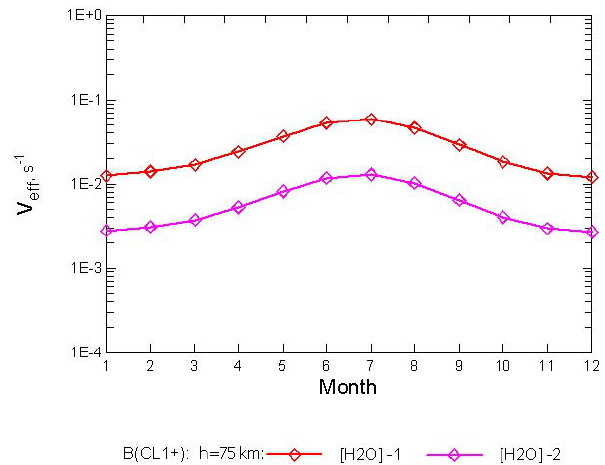
) efficiency calculated 1